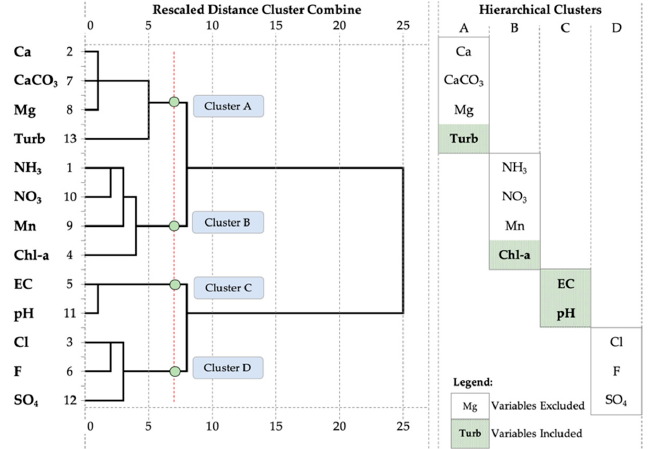
Figure 8. Hierarchical clustering dendrogram model for water quality variables using Ward’s Linkage and Euclidean Distance method (Hierarchical Cluster Analysis). Source: HCA results from IBM SPSS Statistics [53].